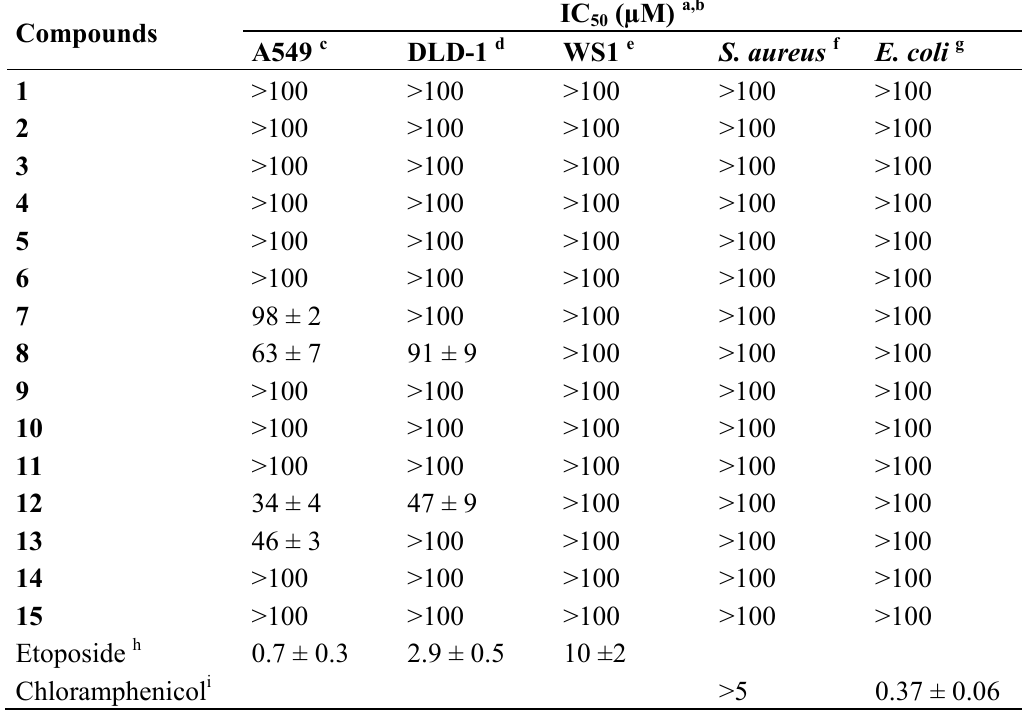
Table 4. In vitro cytotoxicity and antibacterial activities from isolated compounds isolated from fractions F, G and